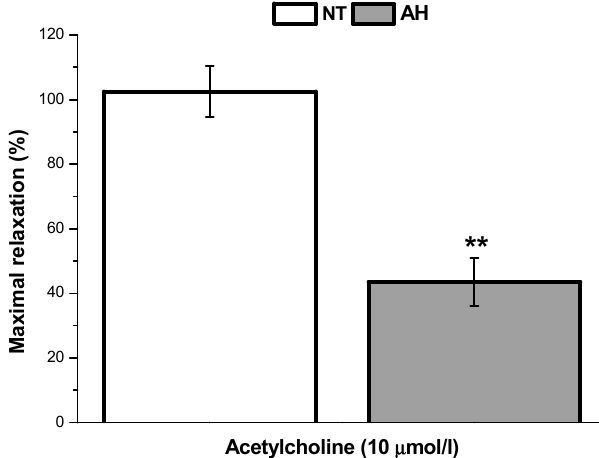
Figure 3. Maximal vasorelaxant responses of serotonin (1 µmol/L)-precontracted human lobar arteries induced by acetylcholine (10 µmol/L) in normotensive patients (NT) and patients with arterial hypertension (AH). Values are the mean ± S.E.M. Significant differences were evaluated by one-way ANOVA. Bonferroni post hoc test was used to describe the differences in mean values of the experimental groups. ** p < 0.01 with respect to the NT response.